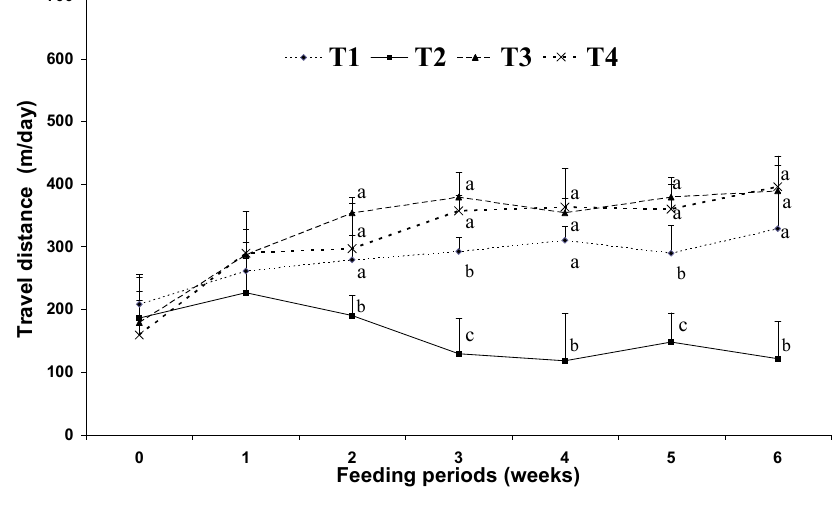
Figure 4. Effect of binding of conjugated linoleic acid with biopolymers on voluntary travel distance in mice fed high- and low-fat diets. Significance was set at p <